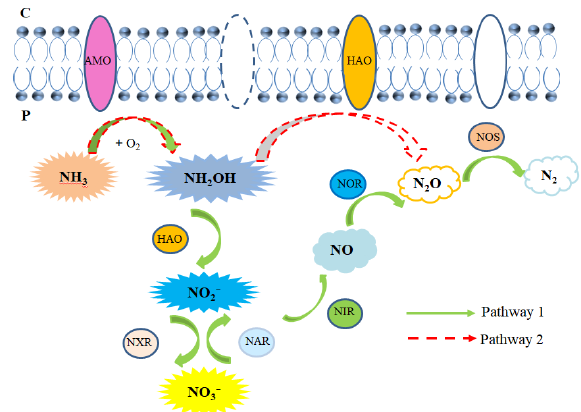
Figure 10. Possible pathways of aerobic nitrogen removal. Note: C: cytoplasm, P: periplasm, AMO: ammonia monooxygenase, HAO: hydroxylamine oxidase, NXR: nitrite oxidoreductase, NAR: nitrate reductase, NIR: nitrite reductase, NOR: nitric oxide reductase, NOS: nitrous oxide reductase.